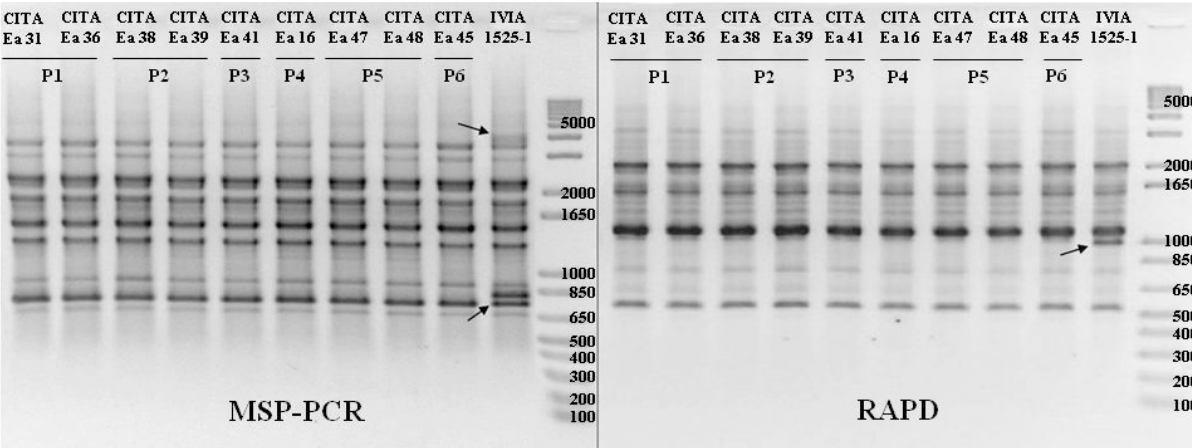
Figure 5. DNA banding pattern obtained for nine Erwinia amylovora strains from the six fire blight areas in Zaragoza (Spain) (P1 to P6) by MS-PCR fingerprints obtained with primer M13 (left), and RAPD fingerprints obtained with primer OPC-19 (right). Arrows indicate additional bands obtained from the E. amylovora strain IVIA 1525-1. Nine CITA strains were iso- lated from Zaragoza (Spain) and strain IVIA 1525-1 originated from País Vasco (Spain).